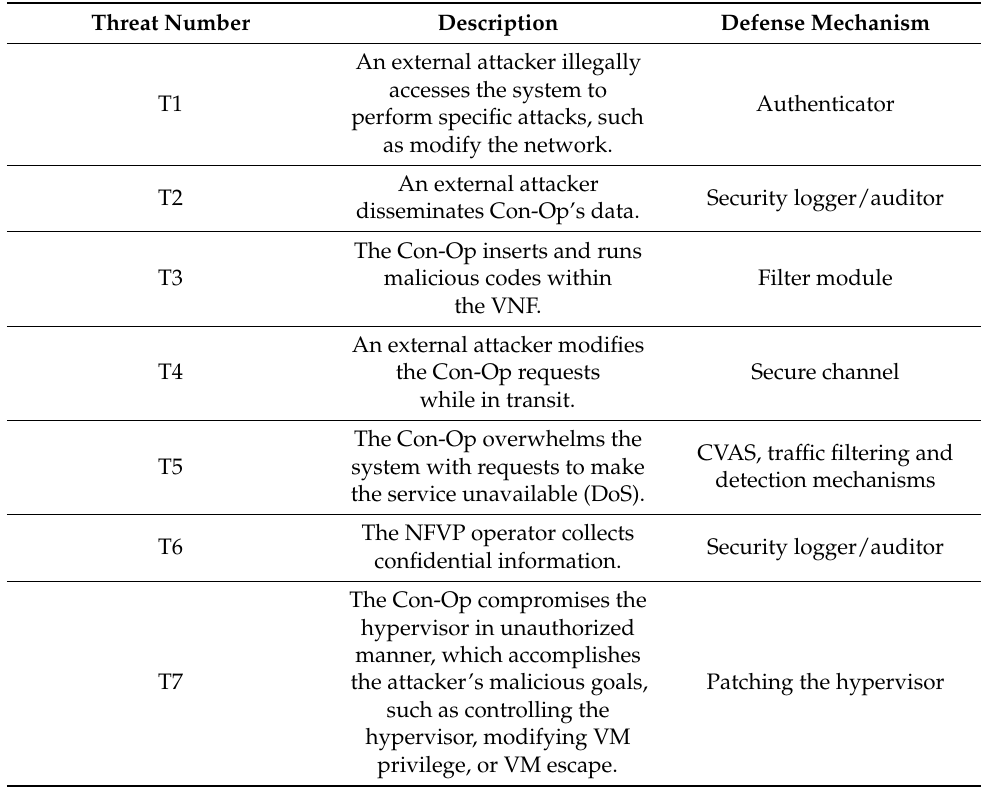
Table 2. Threats list and its mitigation